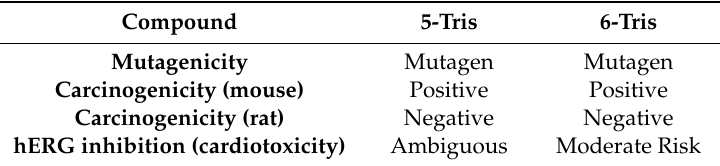
Table 4. Predicted toxicity profile of 5-Tris and